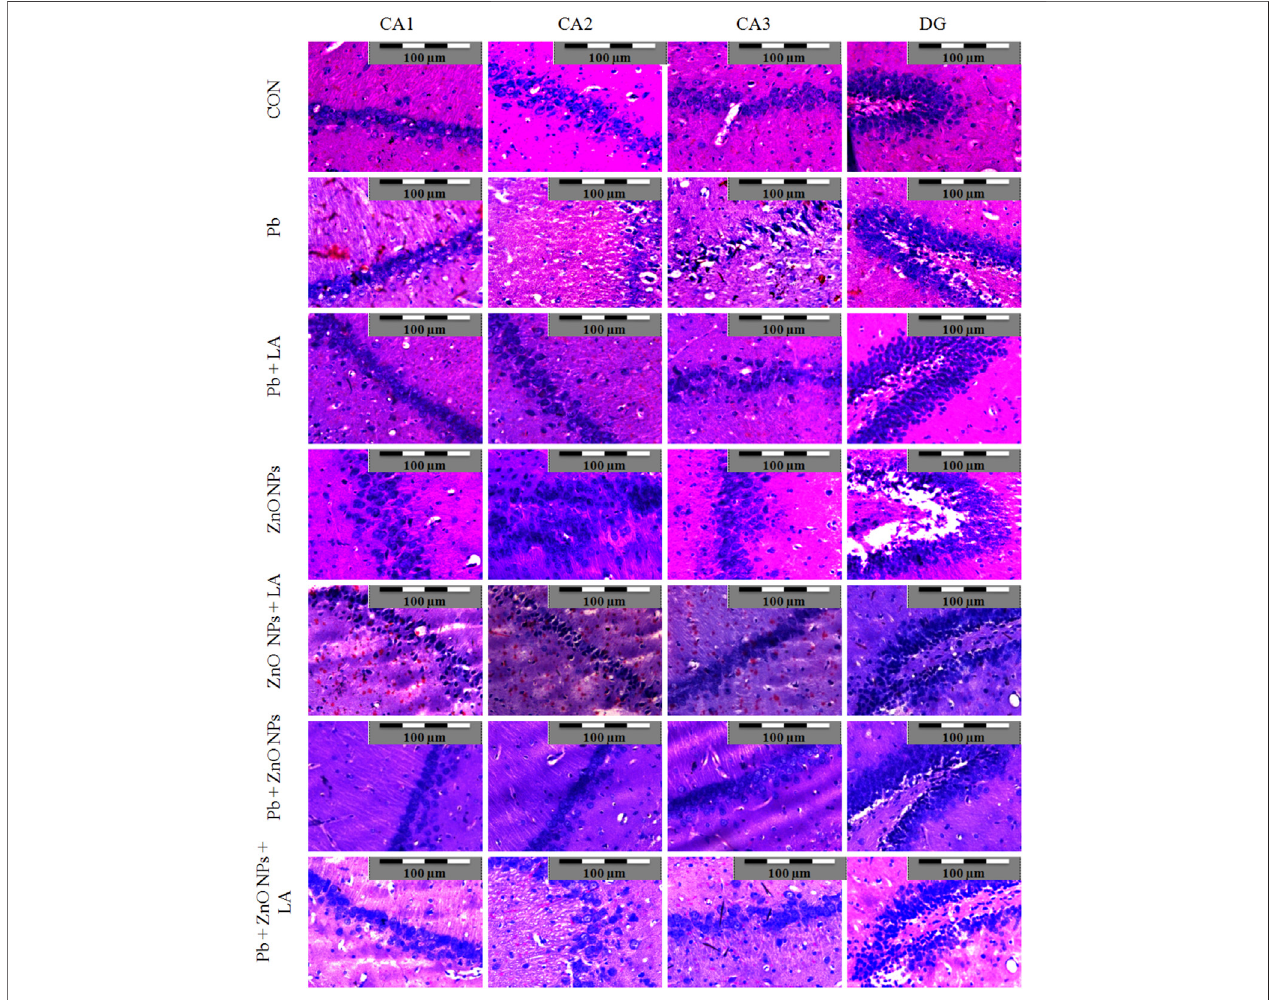
FIGURE 15 | Photomicrographs of the hippocampus of experimental animals. Lead- and ZnO NP – treated groups showing altered cell density in the CA1, CA2, CA3, and DG regions.